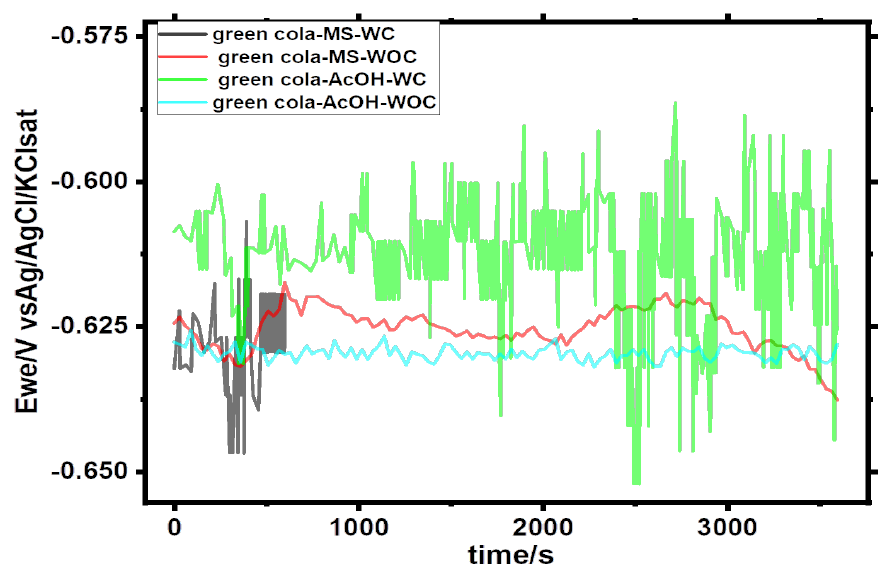
Figure 1. Open circuit potential of Green Cola samples with (WC) and without (WOC) an organic coating in main (MS) and acetic acid (AcOH) solutions; Ewe: working electrode potential.